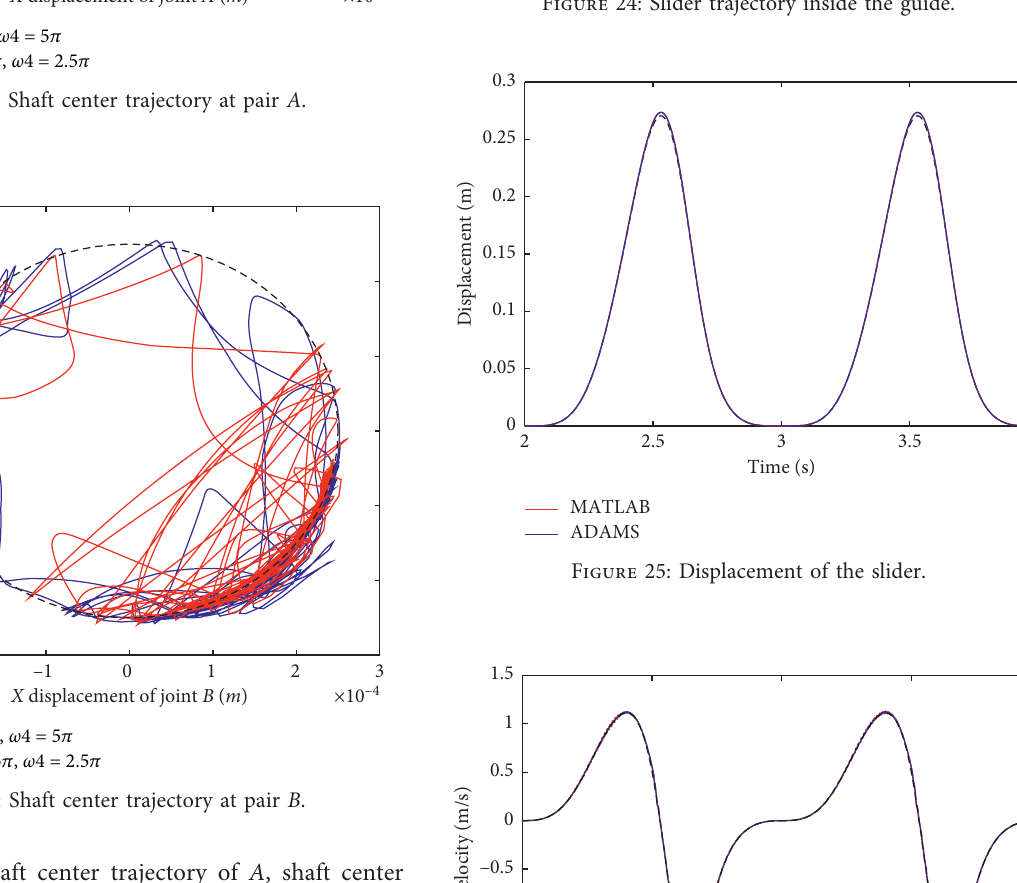
Figure 24: Slider trajectory inside the guide.